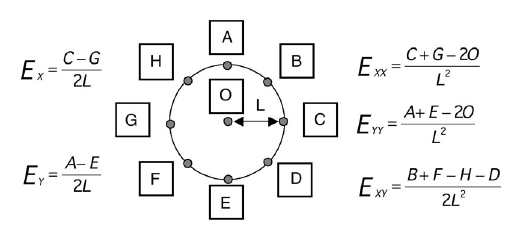
Fig. 9. The arrangement of electrodes of the pro- posed «nine-points» array. Measured finite-differ- ence approximation for the first and second deriva- tive of the electric potential are also shown in the fig- ure. Latin letters designate potentials suitably locat- ed electrodes.